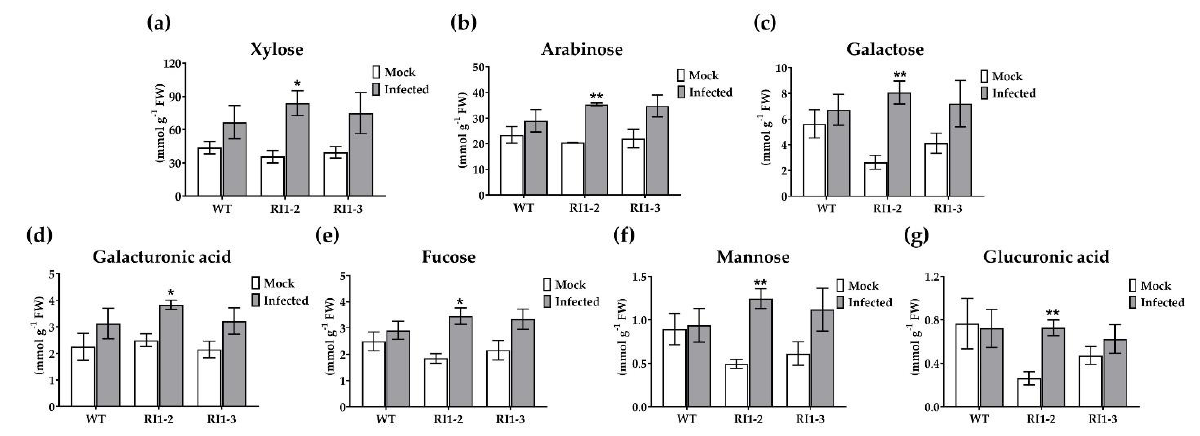
Figure 2. Cell wall monosaccharide composition (mmol g −1 fresh weight) of 3-week-old rice leaves from wild-type (WT) and OsVTC1-1 RNAi lines at 4 days after inoculation with Guy11 isolate. ( a ) Xylose; ( b ) arabinose; ( c ) galactose; ( d ) galacturonic acid; ( e ) fucose; ( f ) mannose; ( g ) glucuronic acid. Data are presented as the mean ± standard error of three replicates. Asterisk indicates statistically significant differences between mock and infected plants for each rice line analyzed using Student’s t -test (* p < 0.05 and ** p < 0.01).